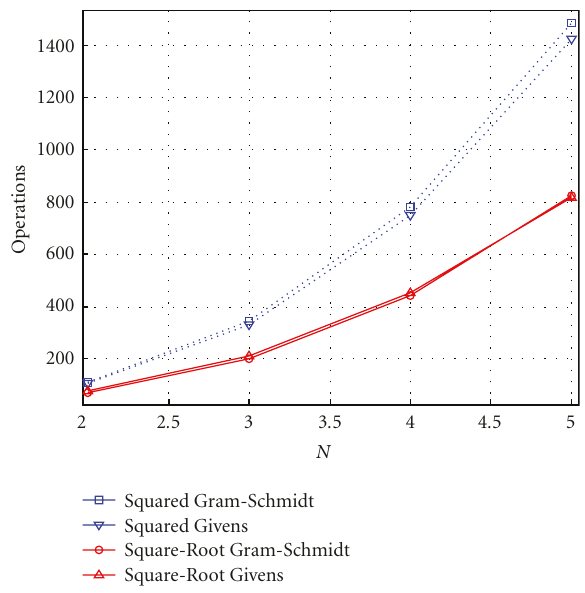
Figure 4: Operation count for each